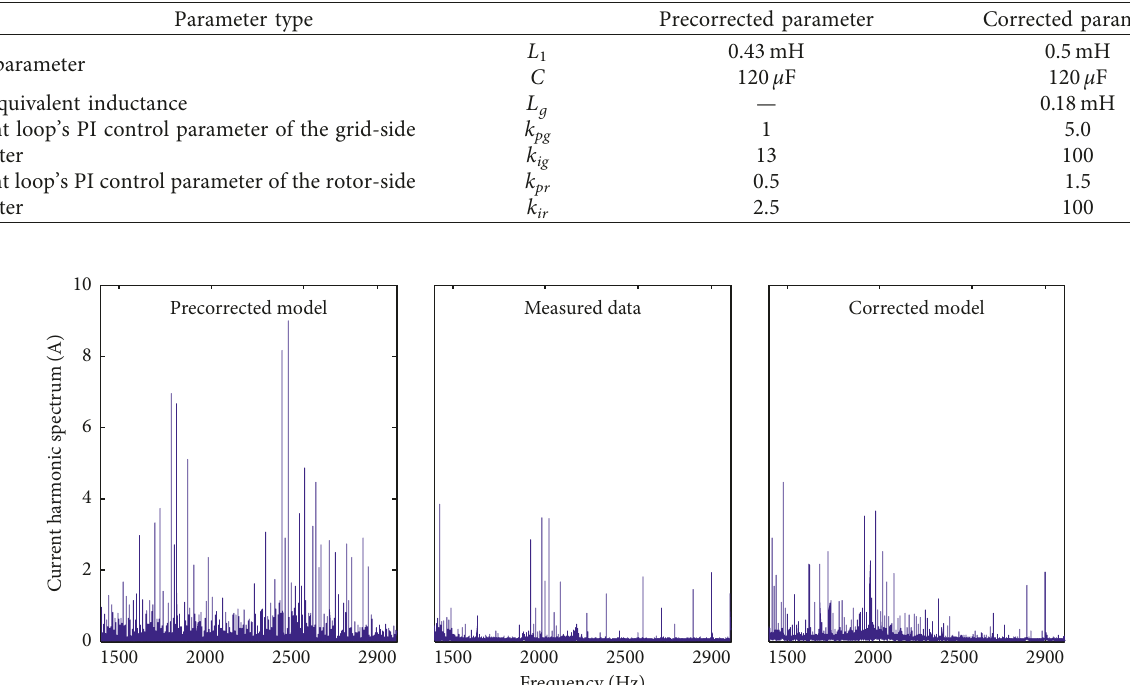
Figure 20: Comparison before and after harmonic model correction of the